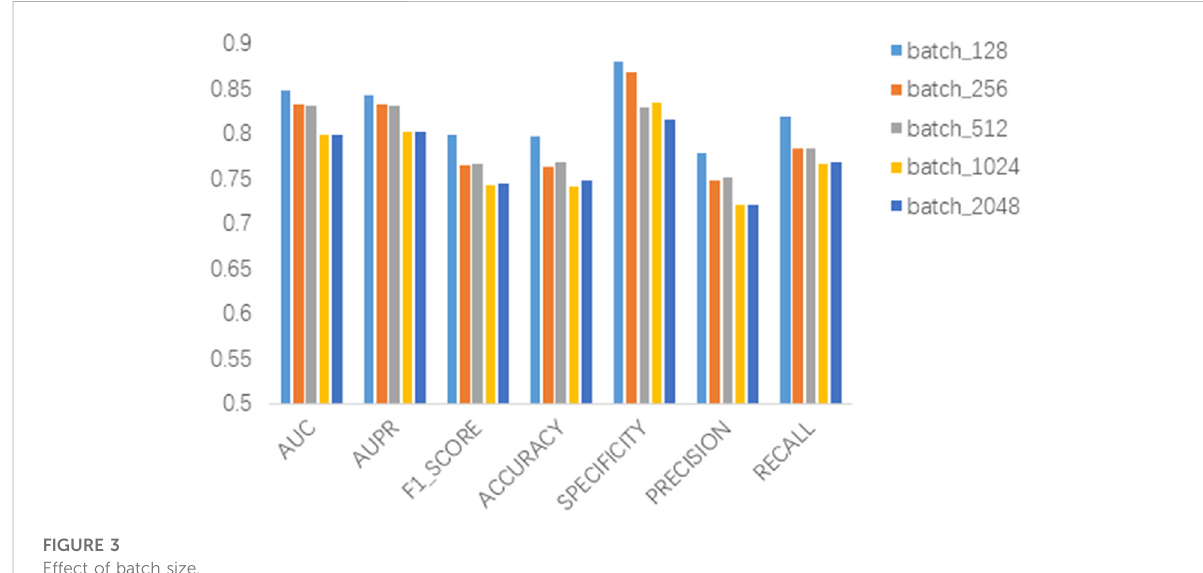
FIGURE 3 Effect of batch size.